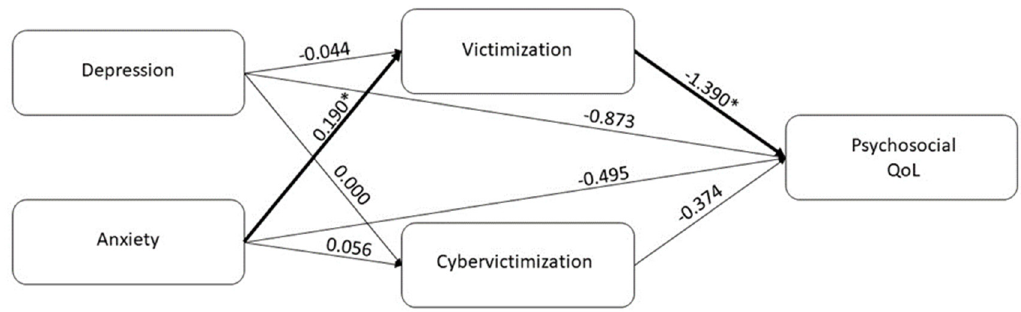
Figure 1. Scheme of the mediation effect of victimization behaviors in the relationship between anxiety and psychosocial quality of life (* p <